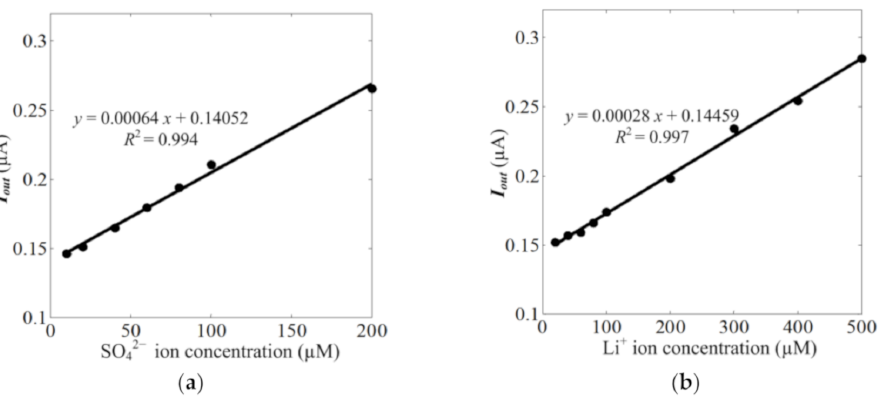
Figure 11. The experimental results of SO 42 − ion and Li + ion concentration measurement. ( a ) The input-output characteristics of C 4 D sensor for SO 42 − ion concentration measurement. ( b ) The input-output characteristics of C 4 D sensor for Li + ion concentration